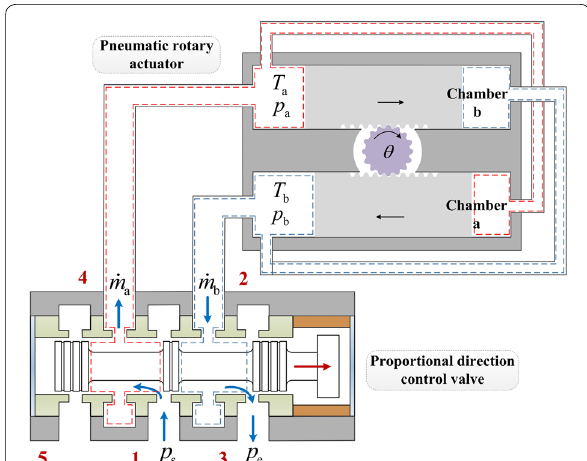
Figure 4 Schematic diagram of the valve-controlled cylinder system